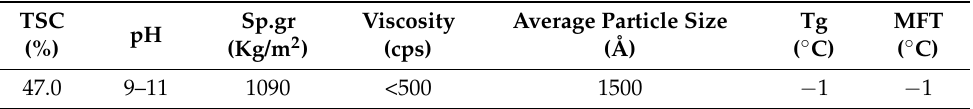
Table 1. Physical properties of SBR latex.